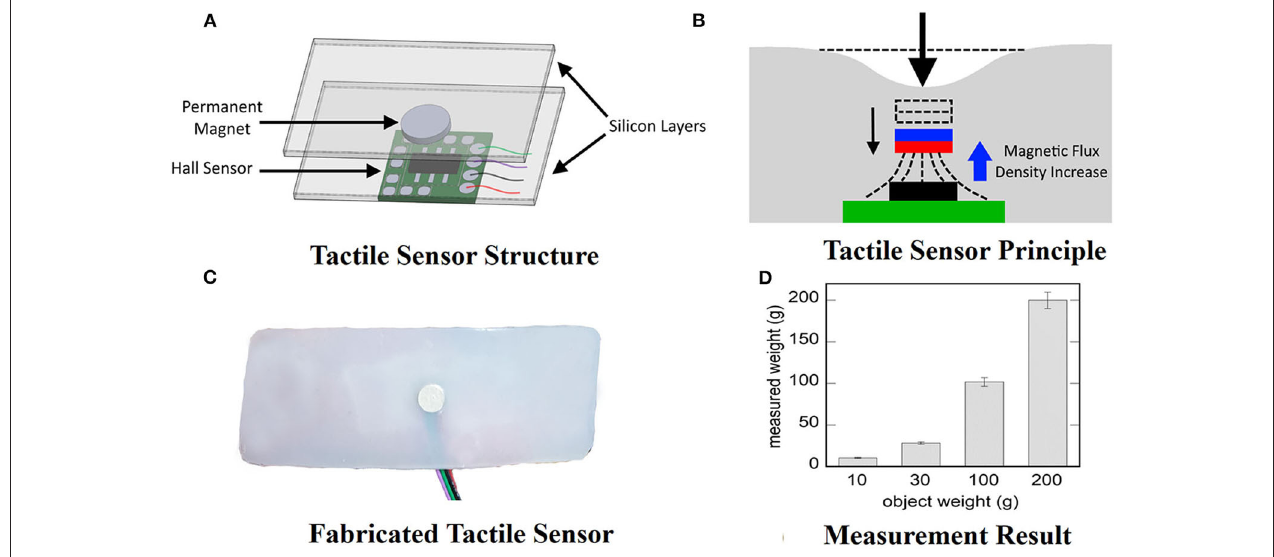
FIGURE 7 | Tactile sensor to manipulate an object with the robotic hand. (A) Tactile sensor structure. (B) Tactile sensor working principle. If the surface is pressed down, the permanent magnet moves closer to the hole sensor, increasing the magnetic flux density. (C) Photo of a fabricated tactile sensor. (D) The measured weight of reference objects. Error bars indicate standard errors.